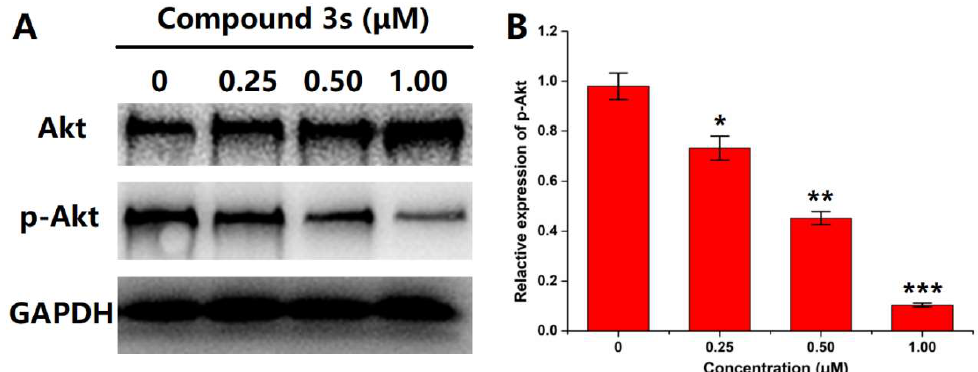
Figure 2. ( A ) The expression levels of Akt, phosphorylated Akt (p-Akt) and GAPDH in HepG2 cells incubated with various concentrations of compound 3s (0, 0.25, 0.50, 1.00 μM); ( B ) Quantitation analysis of the p-Akt level. Data were expressed as Mean ± SD ( n = 3). * p < 0.05, ** p < 0.01 and *** p < 0.005 vs. the control.